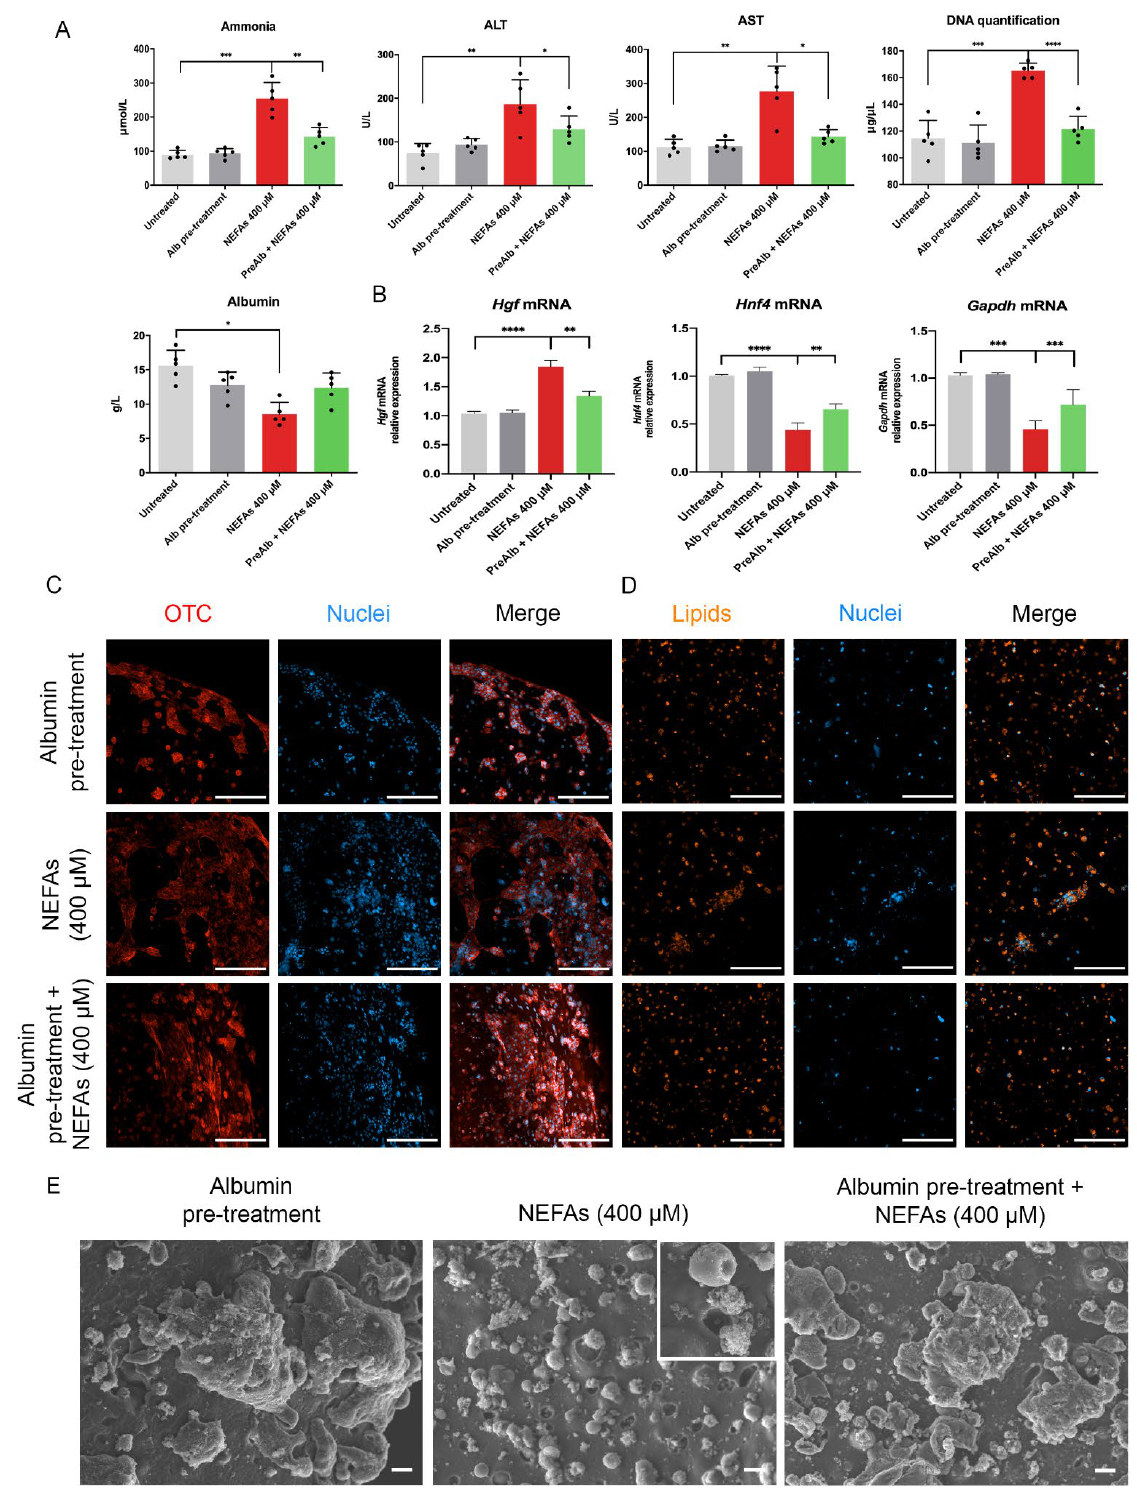
Figure 6. Albumin pre-treatment protect 3D hepatocytes upon challenge with NEFAs. ( A ) Biochemical analyses of the supernatant of 3D AML12 cells pre-treated with albumin and challenged with NEFAs for 72 h assessed by clinical standard procedures. ( B ) Real-time qPCR of hepatocyte markers. The untreated condition was used as calibrator. ( C ) Confocal microscopy of a hepatocyte’s functionality marker of 3D AML12 cells pre-treated with albumin and challenged with NEFAs for 72 h. Scale bar = 200 µ m. ( D )